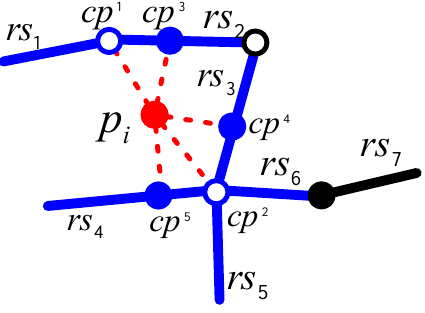
Figure 3. Candidate positions of sampling point p i on neighboring road segments.